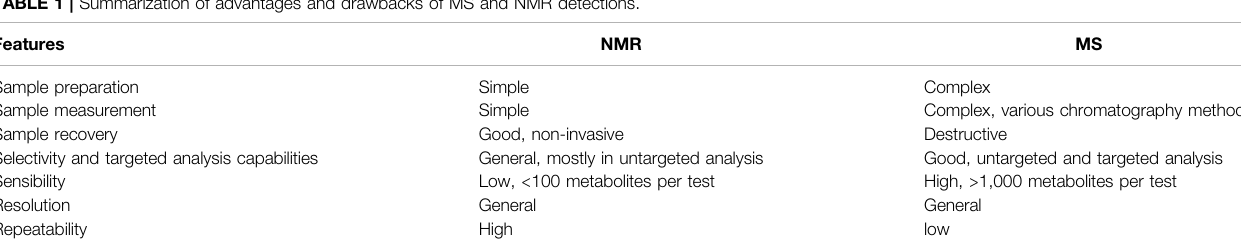
TABLE 1 | Summarization of advantages and drawbacks of MS and NMR detections.